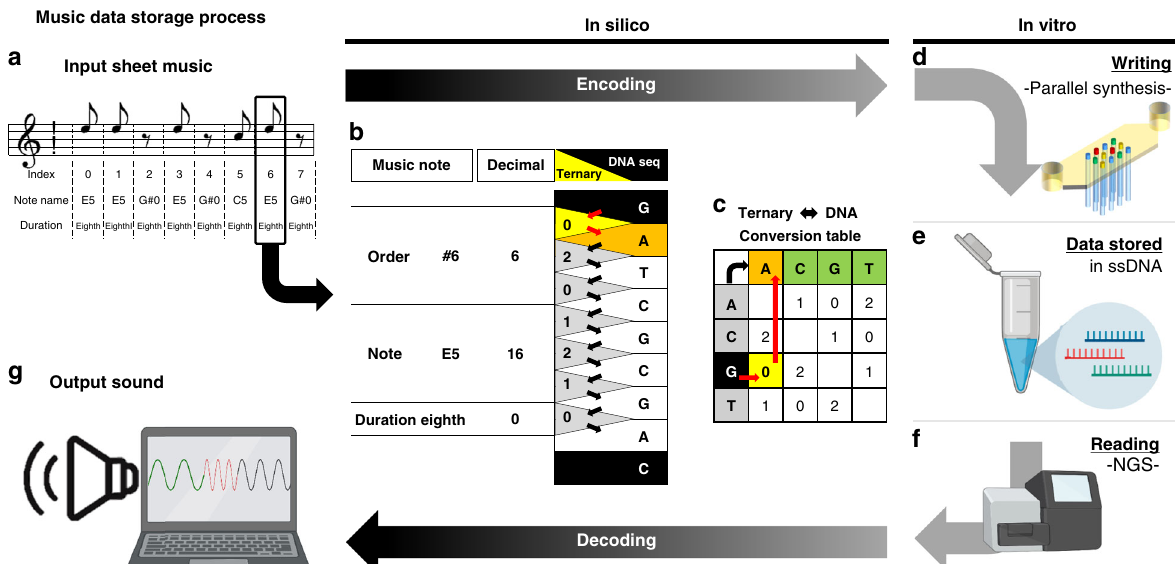
Fig. 4 Demonstration of digital music data storage in DNA oligonucleotides enzymatically synthesized in multiplex: music data storage process. a A snapshot of the simpli fi ed melody from the two fi rst measures of the 1985 Nintendo Entertainment System video game Super Mario Brothers “ Overworld Theme ” piano sheet music. Each note and rest of the melody was indexed as #0 through #11 and stored into one of the 12 unique DNA oligonucleotides synthesized in multiplex on the (3 ⋅ 4) array. The full piano sheet music is shown in Supplementary Fig. 7. b Indexed notes and rests were assigned a note number based on a modi fi ed Musical Instrument Digital Information note chart, which also indicates note octave. In addition to the note, the encoding scheme also stores the order and duration each note is to be played. All rests are assigned to the note G# 0 , which is inaudible (25.9 Hz) to normal human